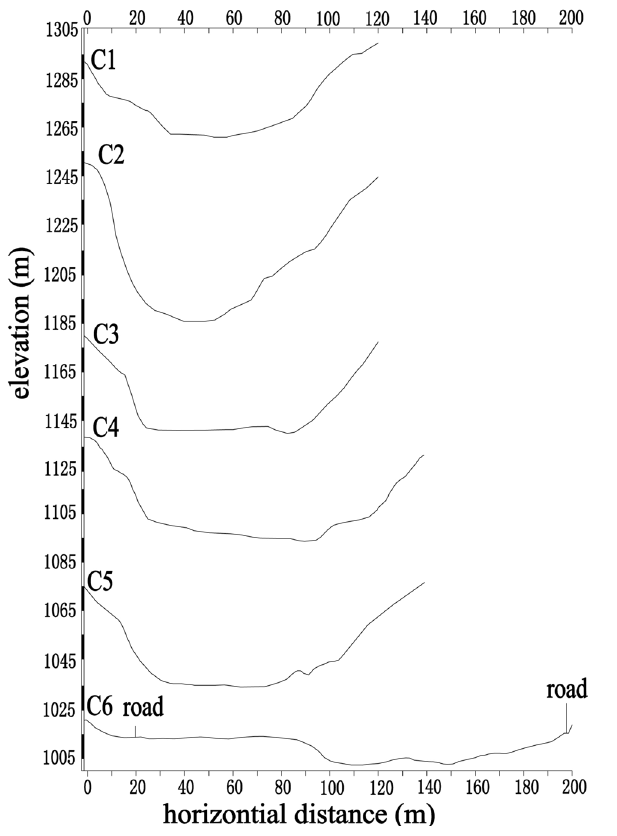
Figure 9. The measured cross-section